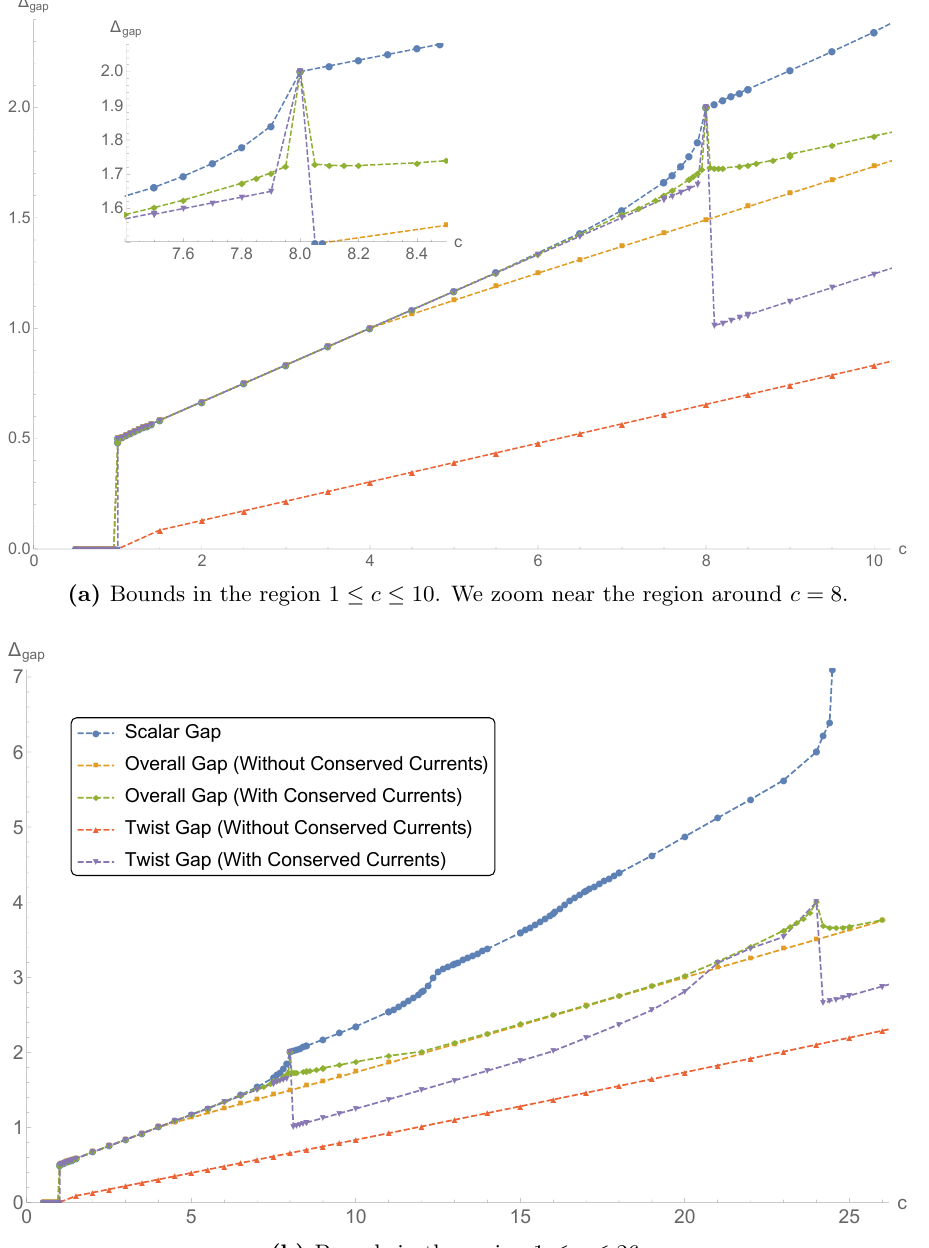
Figure 4. Numerical upper bounds on the scalar gap (cid:1) s , the overall gap (cid:1) o , and the twist gap (cid:1) t .